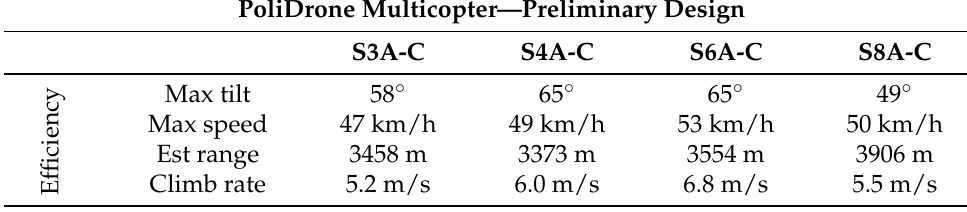
Table 13. Preliminary design of PoliDrone multicopter: flight performance estimations. Calculations are based on a 6000 mAh, 11.1 V battery used up to